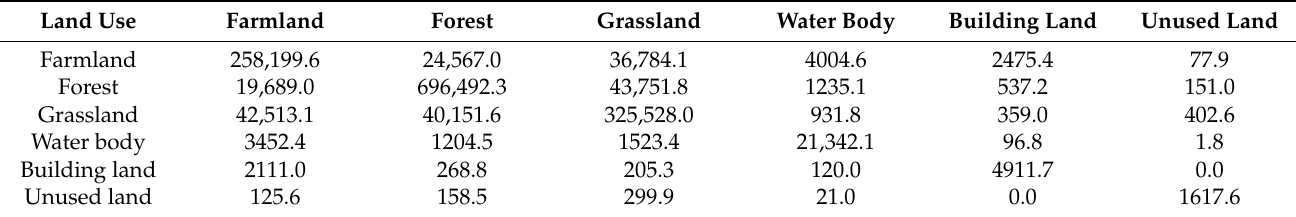
Table 2. Transition matrix of different land use types during